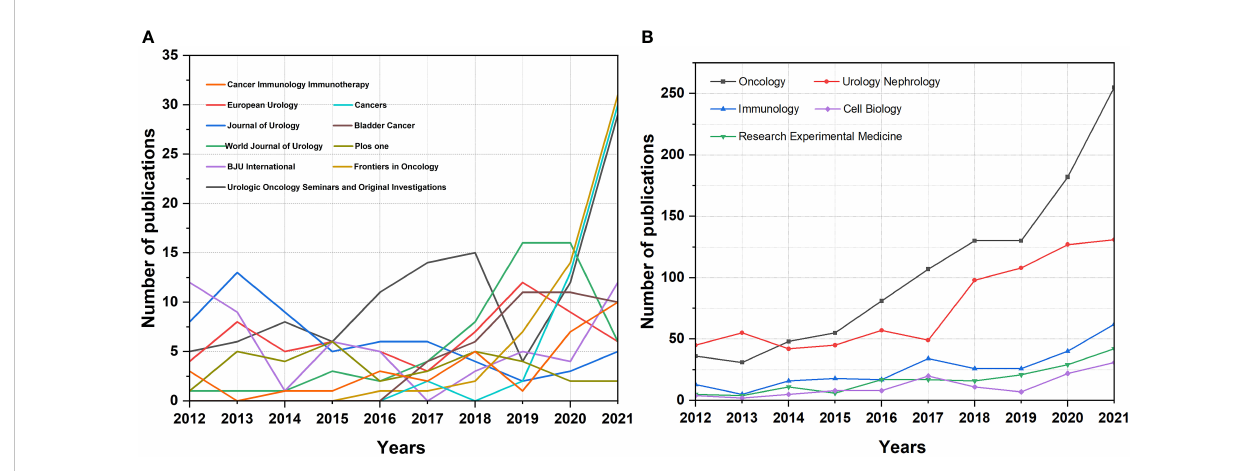
TABLE 3 The top 10 most-cited articles based on TC.